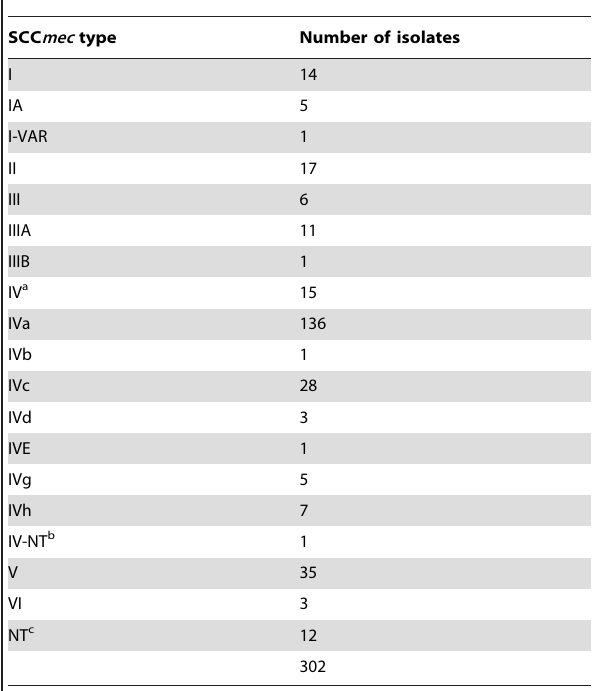
Table 1. SCC mec type of the 302 isolates.